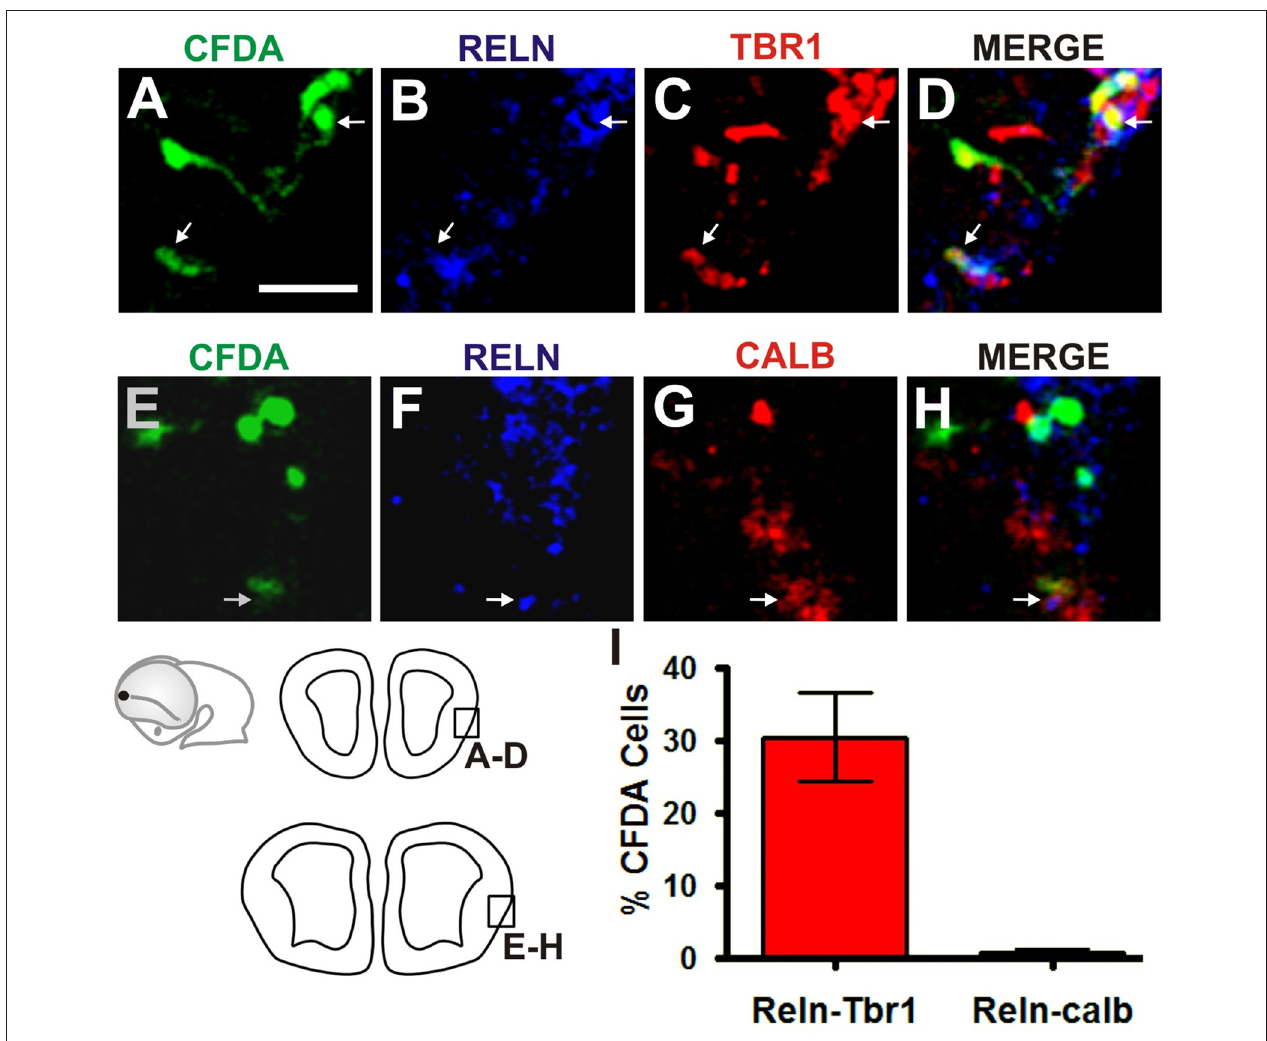
FIGURE 3 | Olfactory CR neurons derived from the Rld. Double immunostaining of telencephalic coronal sections from a representative CFDA-labeled embryo (E10.5 + 24 h in culture). Shown are labelings with CFDA (green) and antibodies against Reelin (blue) and Tbr1 or Calbindin (red) in rostral (A–D) and caudal (E–H) sections. (I) Cell quantitation in the MZ of Reelin and Tbr1 co-labeled neurons (30.4%). Fewer than 0.7% expressed both Reelin and Calbindin. Scale bar 50 µ m.